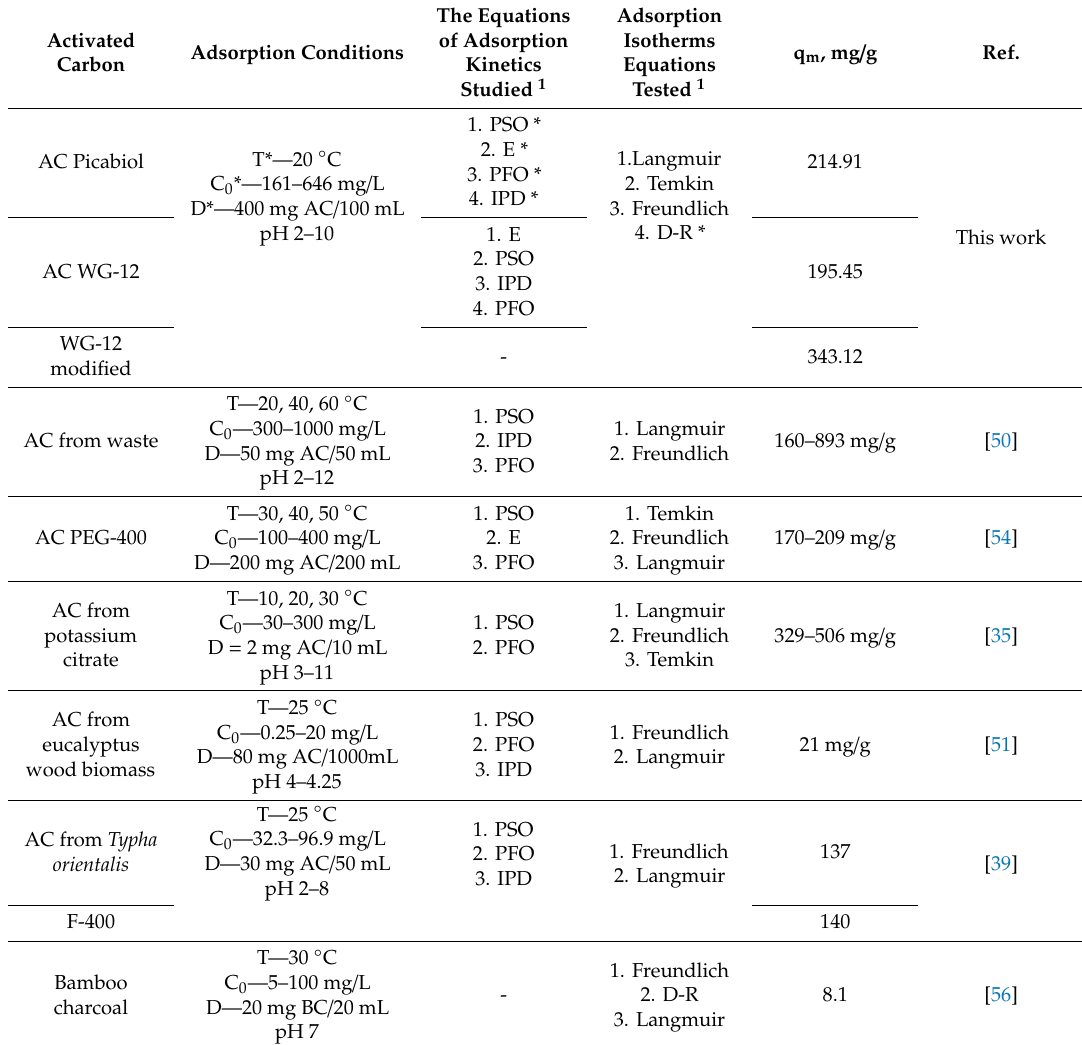
Table 11. Comparison of chloramphenicol adsorption results based on literature